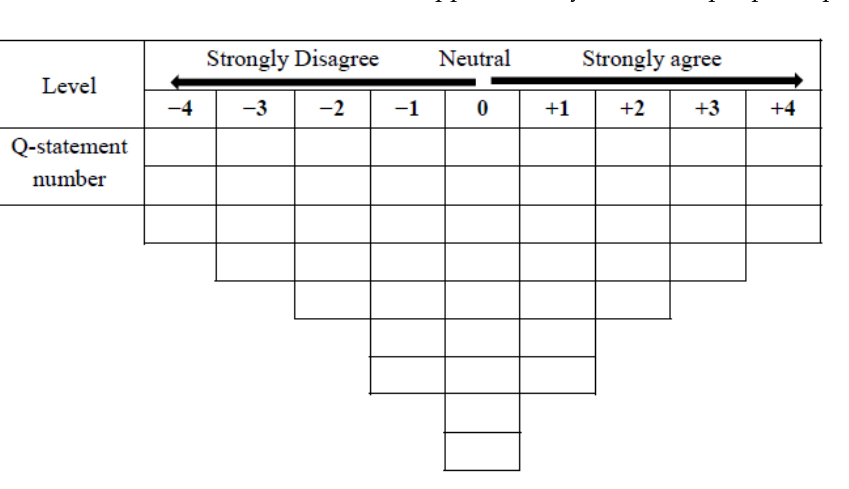
Figure 1. A Q-sort grid for rank-ordering the 47 Q-statements.